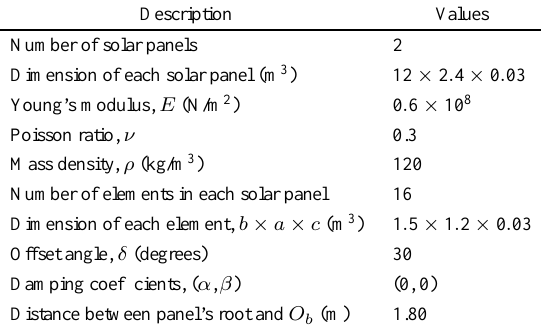
Parameters of the solar panels of